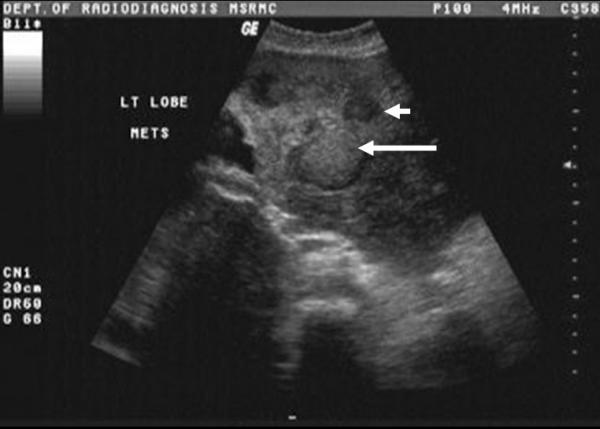
Abdominal ultrasound showing multiple hypoechoiec (short arrow) and hyperechoeic lesions (long arrow) in the liver